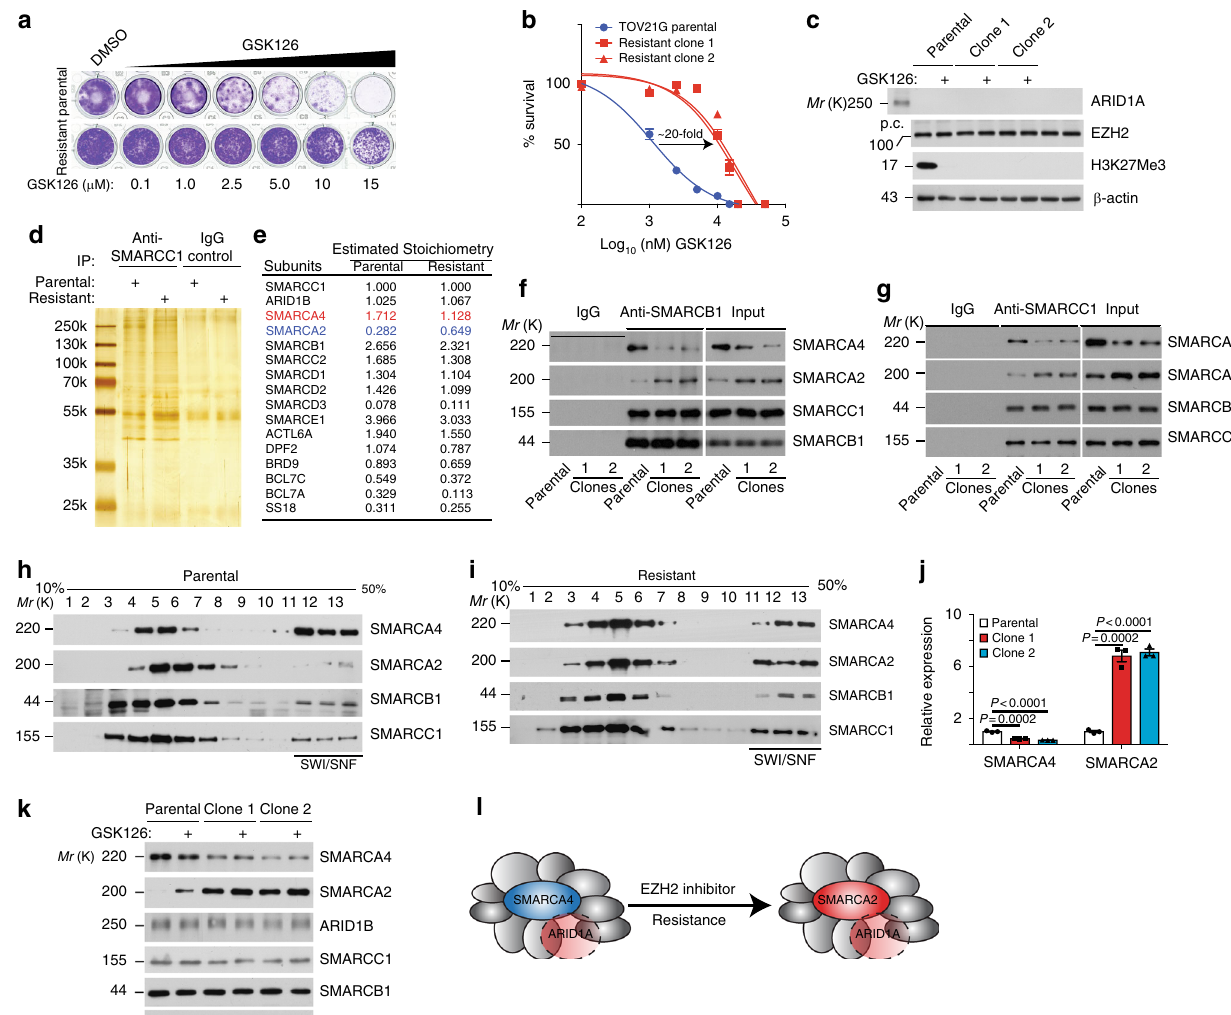
Fig. 1 The SWI/SNF catalytic subunits ’ switch from SMARCA4 to SMARCA2 accompanies the de novo resistance to EZH2 inhibitors. a , b Parental and GSK126-resistant TOV21G cells were subjected to colony formation ( a ) to generate dose response curves to GSK126 ( b ). Arrow points to an ~20-fold increase in GSK126 IC 50 in the resistant clones. c Expression of ARID1A, EZH2, H3K27Me3, and a load control β -actin in the indicated cells passaged with or without 5 μ M GSK126 for 3 days determined by immunoblot. p.c. positive control ARID1A wild-type RMG1 cells. d , e Immunoprecipition of core SWI/ SNF subunit SMARCC1 was separated on a silver stained gel ( d ), or subjected to LC-MS/MS analysis e . Stoichiometry of the SWI/SNF subunits identi fi ed was normalized to SMARCC1. f , g Co-immunoprecipitation analysis using antibodies to core subunit SMARCC1 ( f ) or SMARCB1 ( g ) show the switch from SMARCA4 to SMARCA2 in resistant cells. An isotype-matched IgG was used as a control. h , i Sucrose sedimentation (10 – 50%) assay of SWI/SNF complex from parental ( h ) or resistant cells ( i ). j , k Expression of SMARCA4 and SMARCA2 in the indicated cells determined by qRT-PCR ( j ) or immunoblot ( k ). l A schematic model: the catalytic subunits from SMARCA4 to SMARCA2 accompanies the de novo resistance to EZH2 inhibitors. Data represent mean ± S.E.M. of three independent experiments ( a – c , f – k ). P -value was calculated via two-tailed t